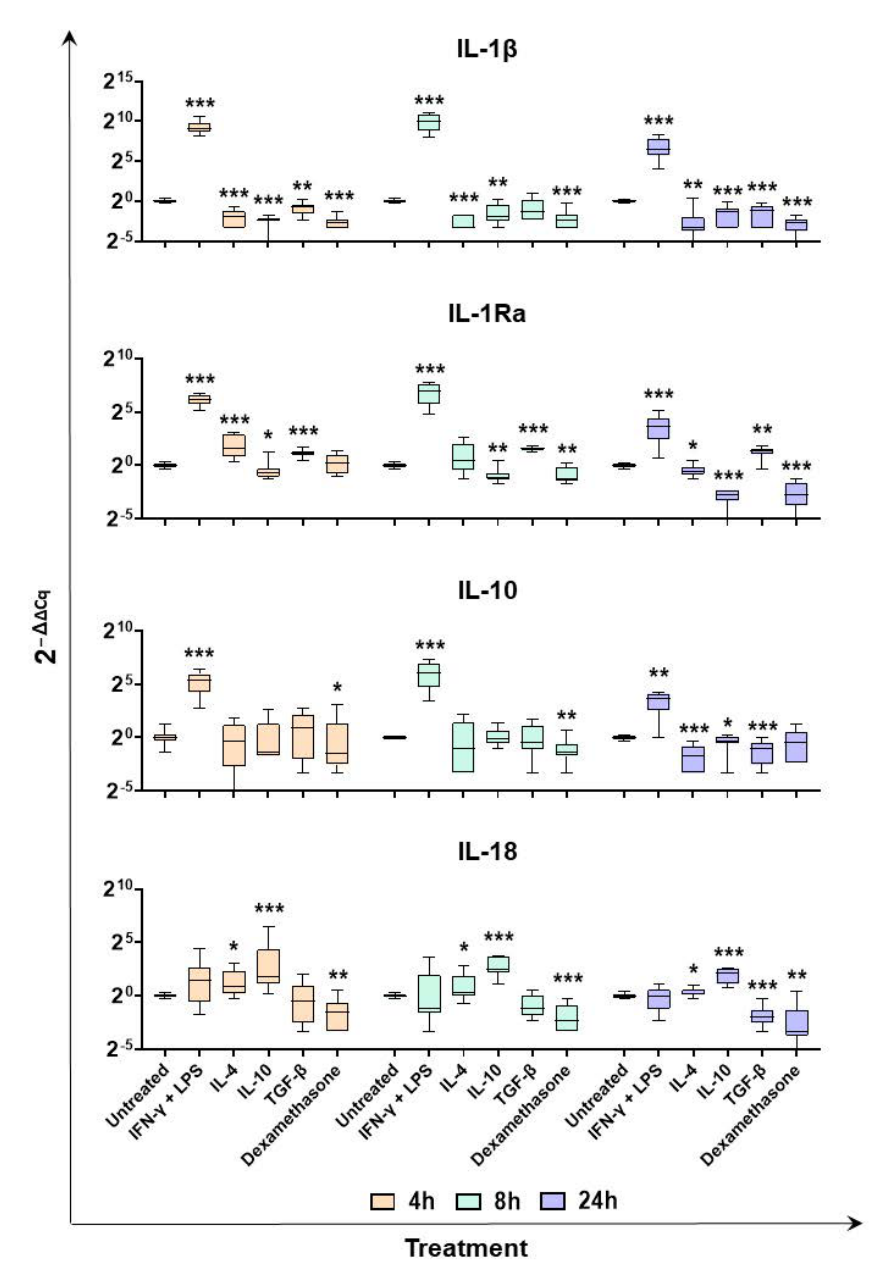
Figure 4. Expression of selected interleukin genes over time in moM Φ stimulated with diverse polarizing factors. Porcine moM Φ were left untreated, or they were stimulated with diverse polarizing factors: IFN- γ + LPS (both at 100 ng/mL), IL-4 (20 ng/mL), IL-10 (20 ng/mL), TGF- β (20 ng/mL), or dexamethasone (20 ng/mL). At 4, 8, and 24 h post-stimulation, gene expression levels of IL-1 β , IL-1Ra, IL-10, and IL-18 were determined using qPCR. At each timepoint, data were normalized to the values of the untreated control (moM Φ ) and expressed as 2 − ∆∆ Cq , where ∆ Cq = Cq (target gene) − Cq (house-keeping gene), and ∆∆ Cq = ∆ Cq (stimulated samples) − ∆ Cq (untreated samples). Data from five independent experiments utilizing different blood donors are presented. Data are displayed as box-and-whisker plots, showing the median and interquartile range (boxes) and minimum and maximum values (whiskers). Values of treated macrophages were compared to the untreated control (moM Φ ), using an unpaired t -test of a Mann–Whitney test. *** p < 0.001, ** p < 0.01, and * p <